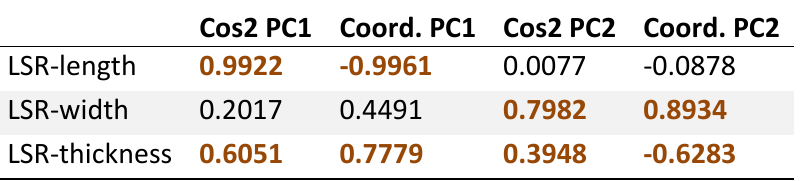
Table 6. Coordinates of the two PCs and their cos 2 from the PCA2 presented in Figure 12. Variables with highest contribution and quality of representation on the PCs are shown in